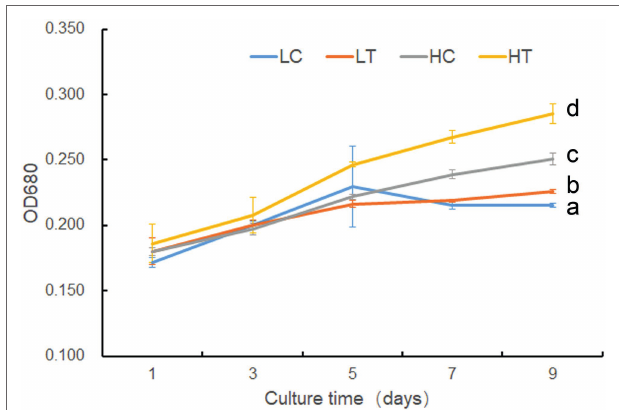
FIGURE 1 | Growth of Symbiodinium sp. under different taurine concentrations. LT, treatment with low concentrations (10 μ l) of taurine (LT); LC an equal amount of NO 3 − was added to low concentrations control cells (LC); HT, treatment with high concentrations (1 mM) of taurine (HT); HC an equal amount of NO 3 − was added to high concentrations control cells (HC). Data points are the means of triplicates and error bars represent the standard deviation. Letters a–d represent significant differences (value of p <0.05) between groups evaluated by Student’s t -test.